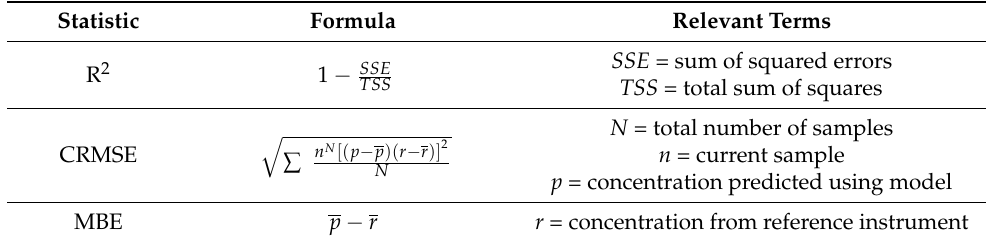
Table 4. Selected Statistics and Relevant